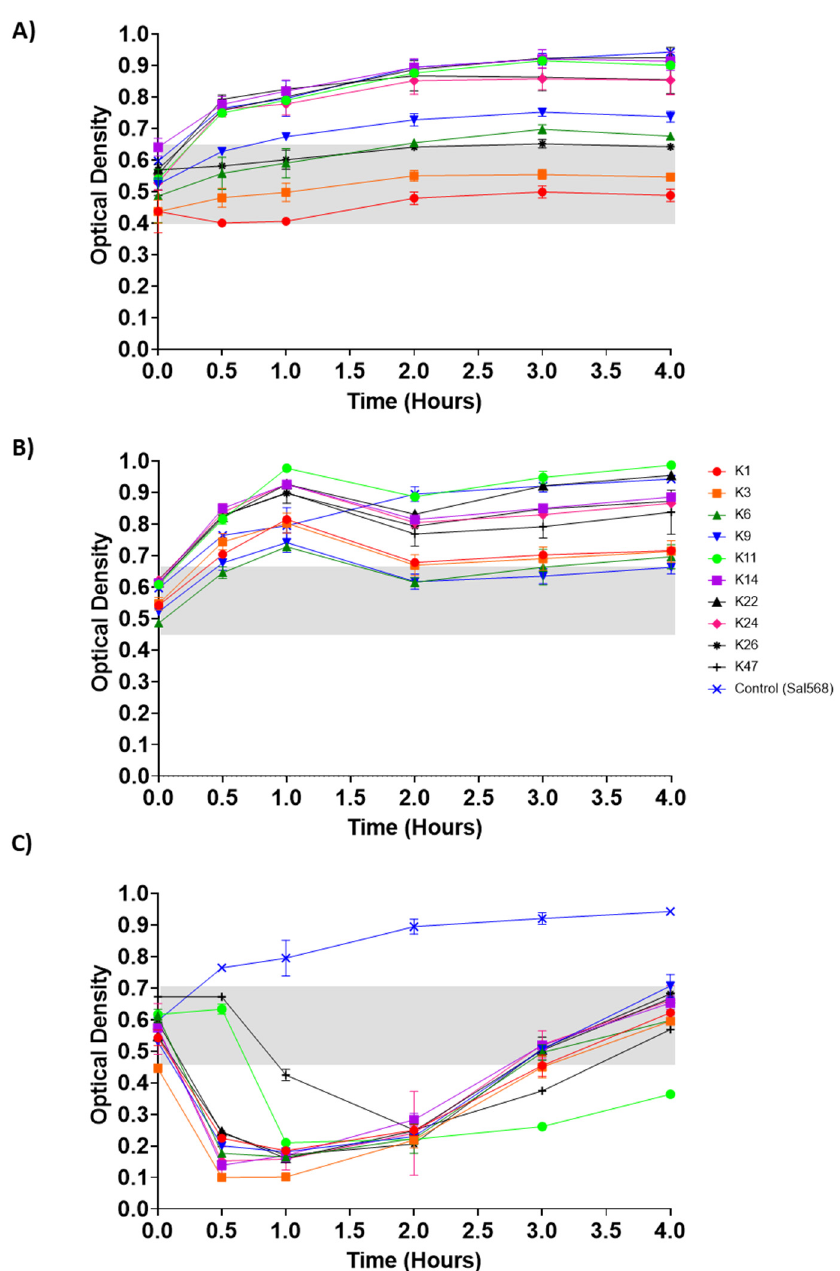
Figure 5. Control of S . Enteritidis growth by phages in pH-adjusted media. TSB was adjusted to pH ( A ) 2, ( B ) 3, and ( C ) 8. The optical density (OD 600 nm ) of the mixture of S . Enteritidis isolate 568 (10 6 CFU/mL) and the 10 phages (4.5 × 10 7 PFU/mL) were measured after 0, 0.5, 1, 1.5, 2, 2.5, 3, 3.5, and 4 h. The grey shading indicates initial OD values at the start of the experiment. All experiments were repeated twice and measured in triplicate. Error bars represent the standard error of the mean (±SE).